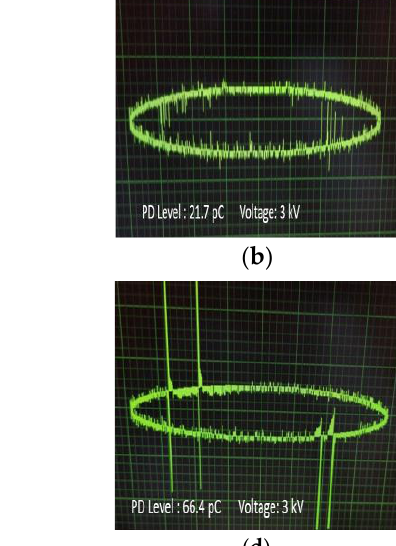
Figure 10. Waveforms of PD pulses at 3 kV AC voltage for the insulating paper impregnated with: ( a ) Net; ( b ) NF1; ( c ) NF2; ( d ) NF3 samples.